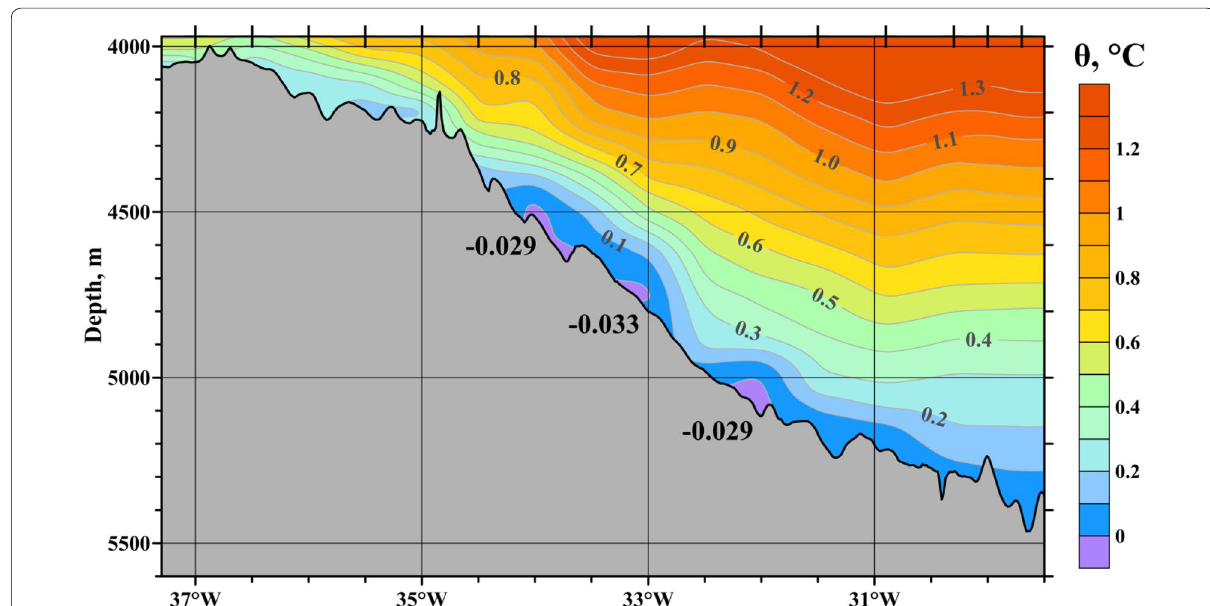
Fig. 7 Distribution of potential temperature θ above the bottom part of the A09 section (2018) over the slope of South America along 24° S. Potential temperatures in the cold cores at the bottom are indicated